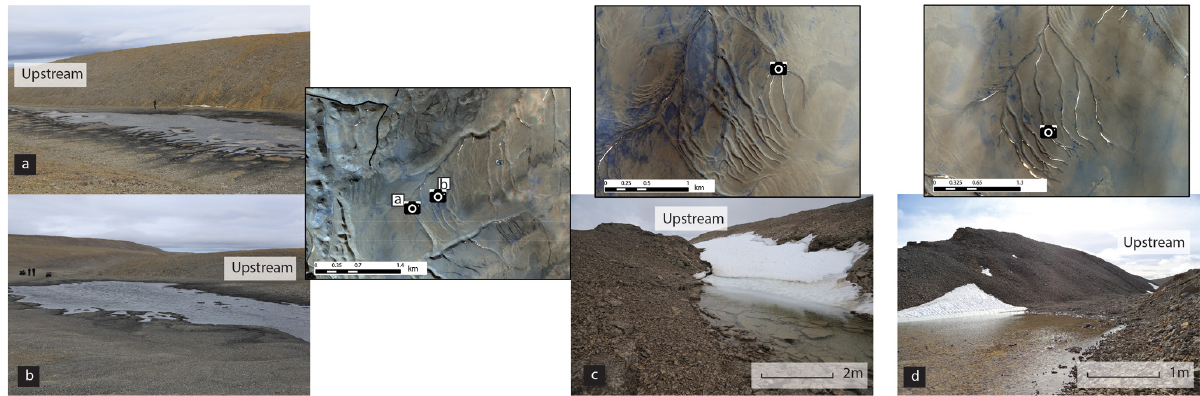
Figure 9. Field images of the shallow depressions and potholes observed. Satellite imagery provide context for the photographs through the camera icons. Note human figures for scale in photos (a) and (b) . Photos (c) and (d) contain a scale bar for reference. Image (c) is an example of an overhanging valley (here covered in snow) followed by a